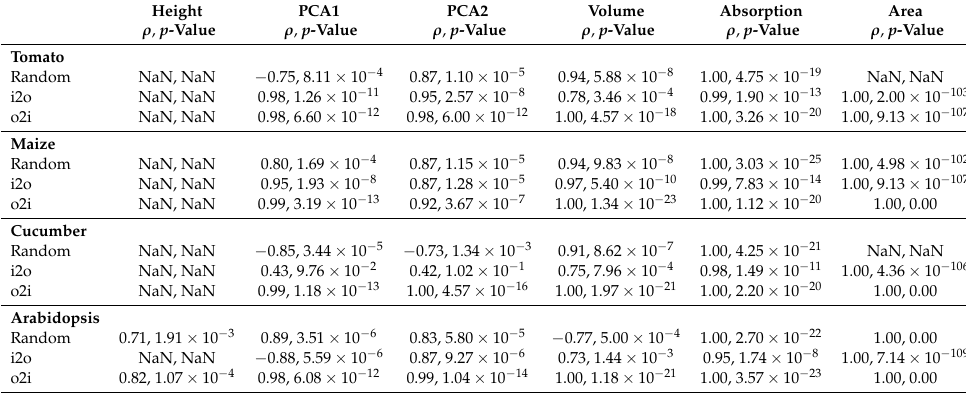
Table 3. Summary of the linear correlation between the phenotypic features from Figure 11 and the visible plant area for all three geometry perturbation scenarios (random, inside-to-outside (i2o), and outside-to-inside (o2i)) in the range of 0–30% including correlation coefficients ( ρ ) and corre- sponding p -values. NaN entries indicate a uncorrelated relationship between a feature and the visible plant